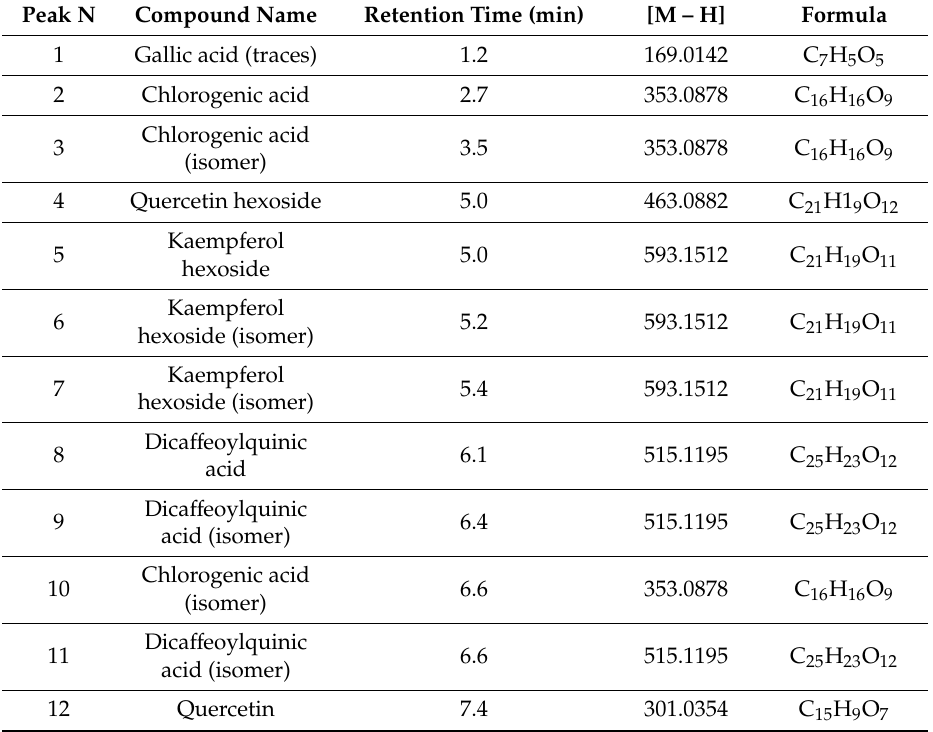
Table 1. Polyphenols identified in Antirhea borbonica plant extract.